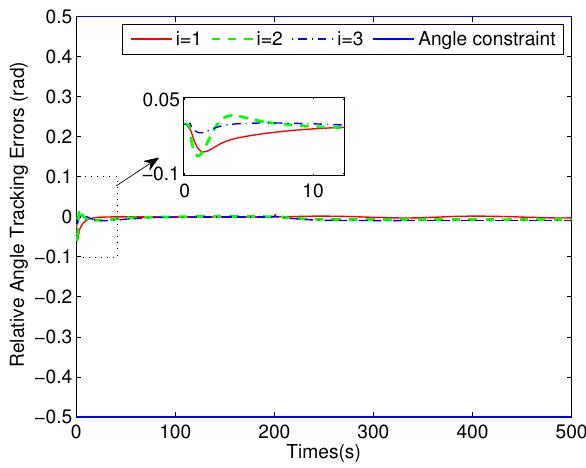
Figure 11. Yaw angle tracking errors along with proposed boundary.